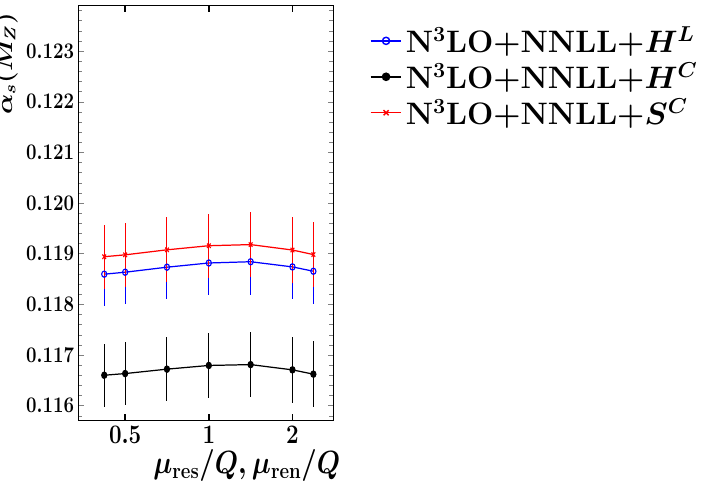
Figure 7 . Dependence of the ( R 2 ) (cid:12)t results on the simultaneous variation of renormalization and resummation scales. The (cid:12)t range is (cid:12)xed to [ (cid:0) 2 : 25 + L ; (cid:0) 1]. 5.2 Simultaneous (cid:12)t of the coupling with the two- and three- jet rates R 2 and R